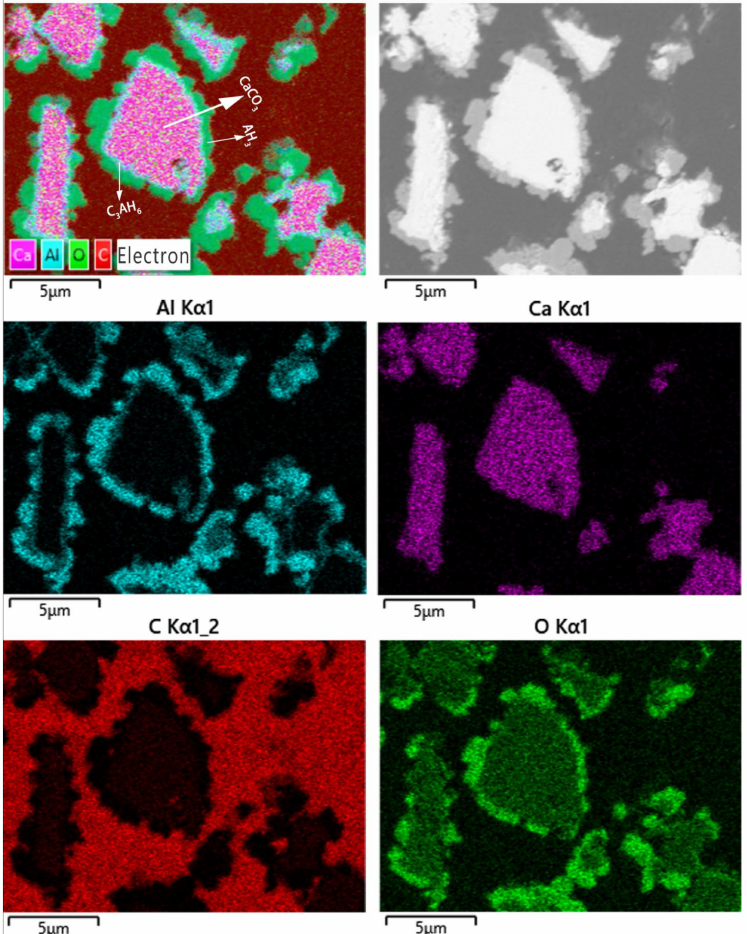
Figure 8. SEM image and EDS mapping of 400–500 mesh ground calcium carbonate